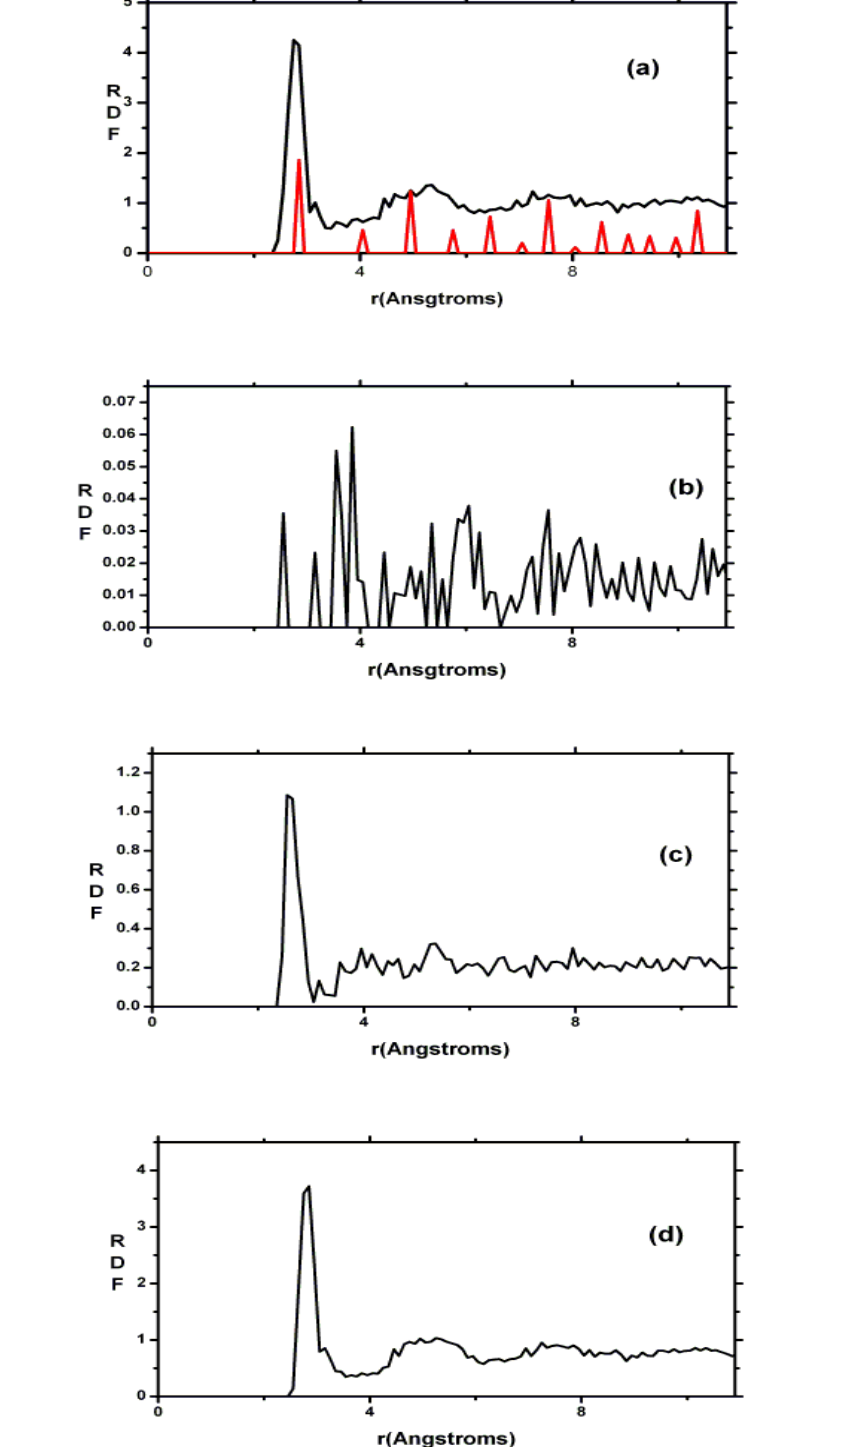
Figure 28. The system la -Al12at%Si relaxed. ( a ) Total RDF; the pRDFs are ( b ) Si–Si; ( c ) Al–Si and ( d ) Al–Al for the 15 Si and 110 Al. The red peaks in ( a ) are the atomic positions of the fcc